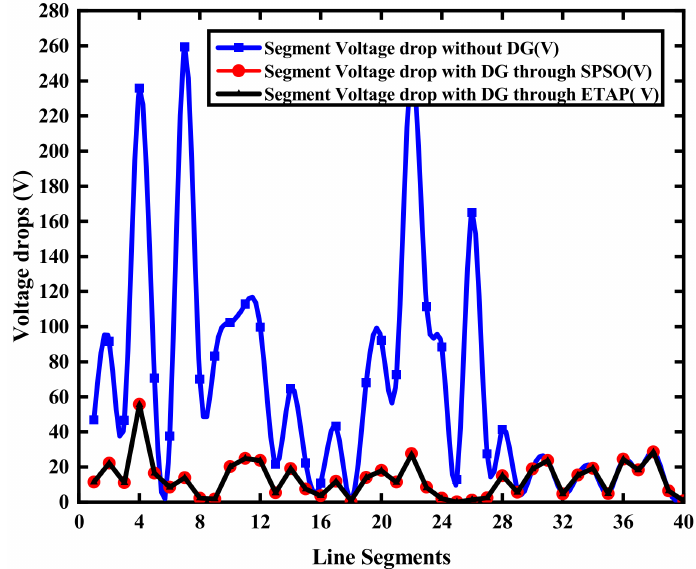
Figure 9. Segment voltage drops with and without DGs.